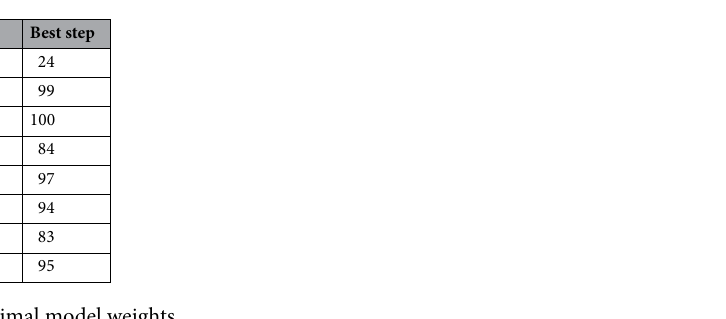
Table 5. Best steps with optimal model